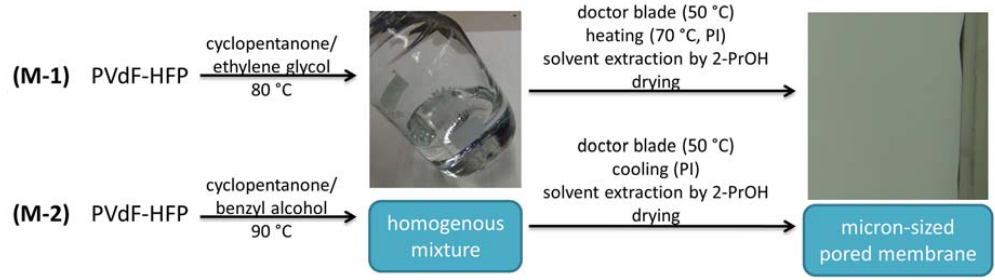
Figure 2. Preparation processes for both micron ‐ sized pored membranes via phase inversion.